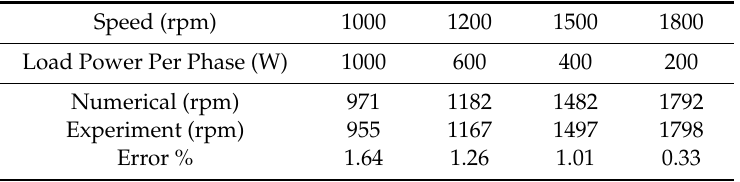
Table 4. Validation